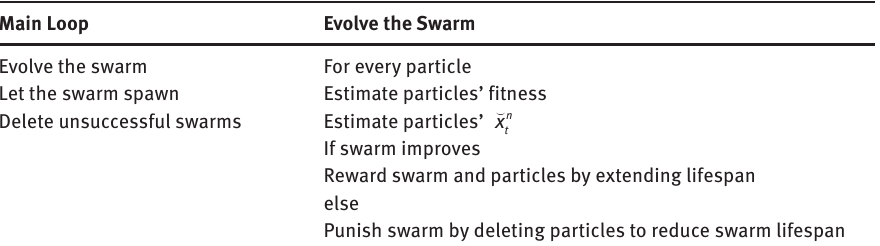
Table 2: DPO Algorithm. Main